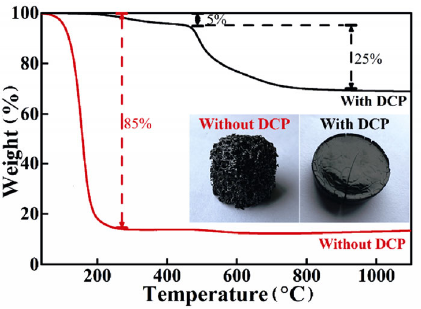
Fig. 4 TG analysis of cross-linked PMVBSZ with and without DCP added. The insets are the optical images of corresponding pyrolyzed